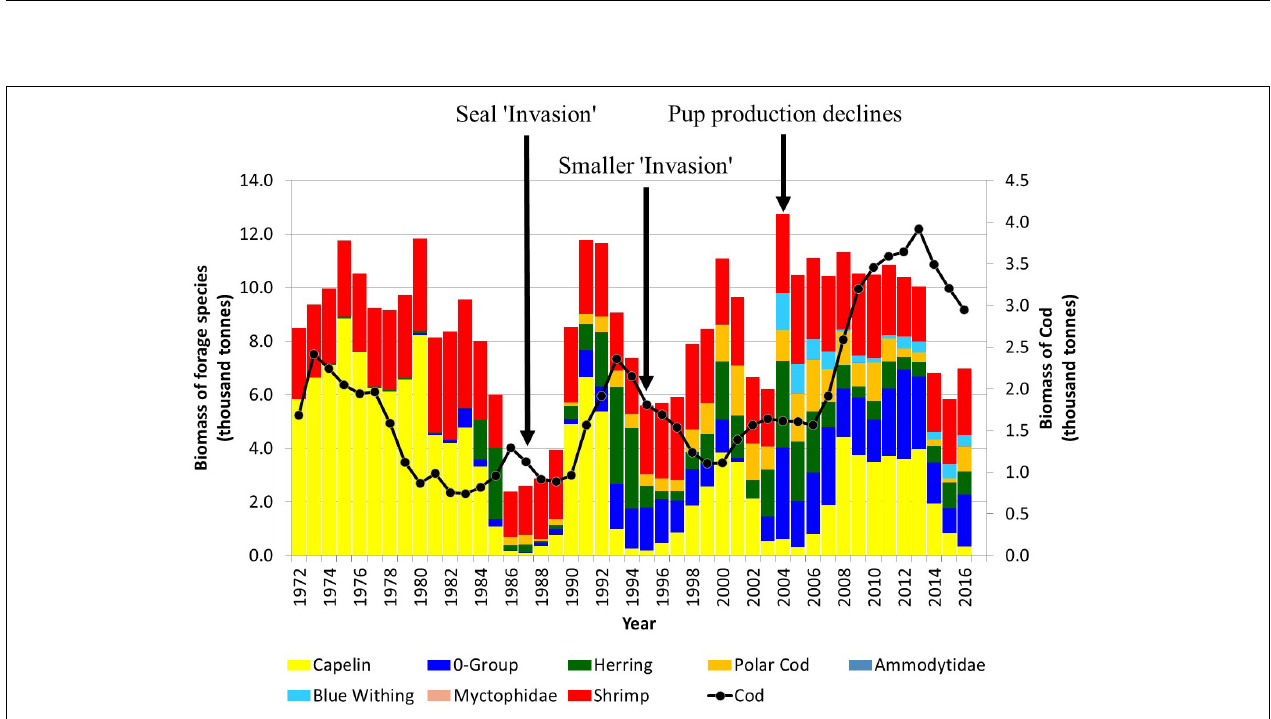
FIGURE 6 | Estimated biomass of forage species and Atlantic cod in the Barents Sea. The timing of seal ‘invasion’ along the Norwegian coast and an abrupt decline in pup production are indicated (modified from Haug et al., 2017; Protozorkevich and van der Meeren, 2020).